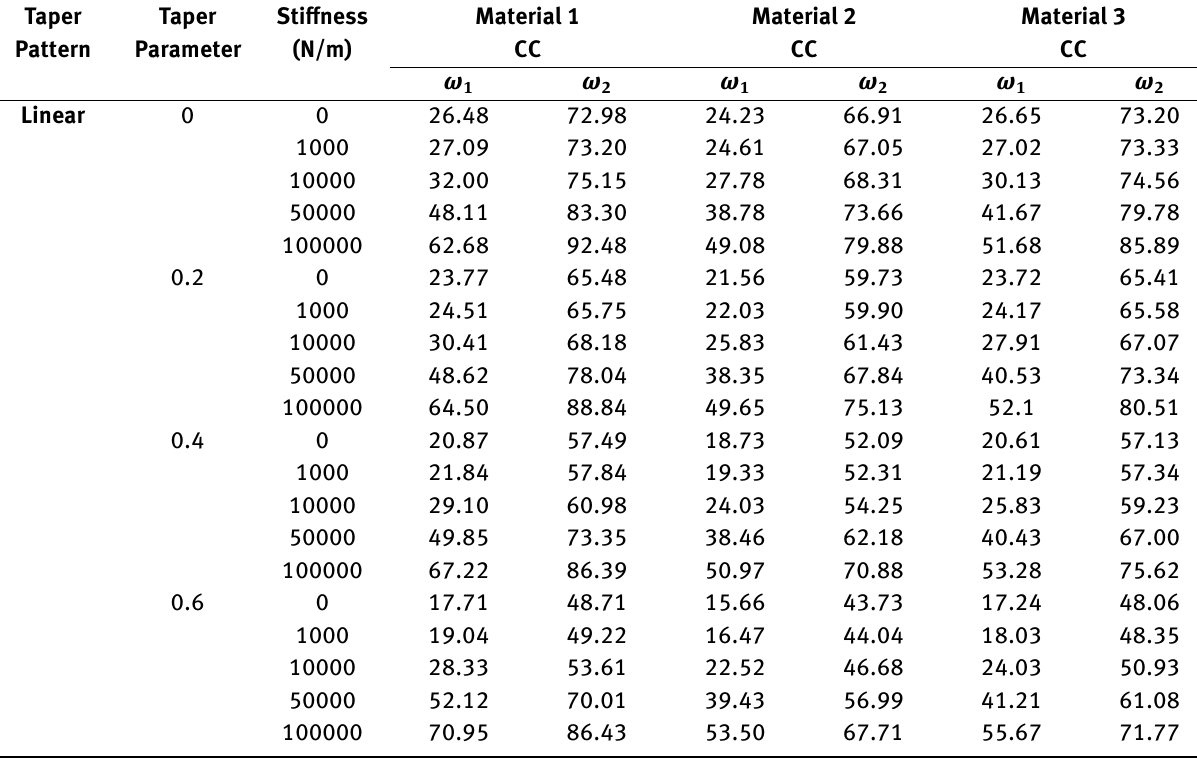
Table 3: Values of natural frequencies for 1 st and 2 nd mode ( ω 1 and ω 2 ) corresponding to linearly tapered clamped AFG beam for different combinations of taper parameter, spring stiffness and material properties.